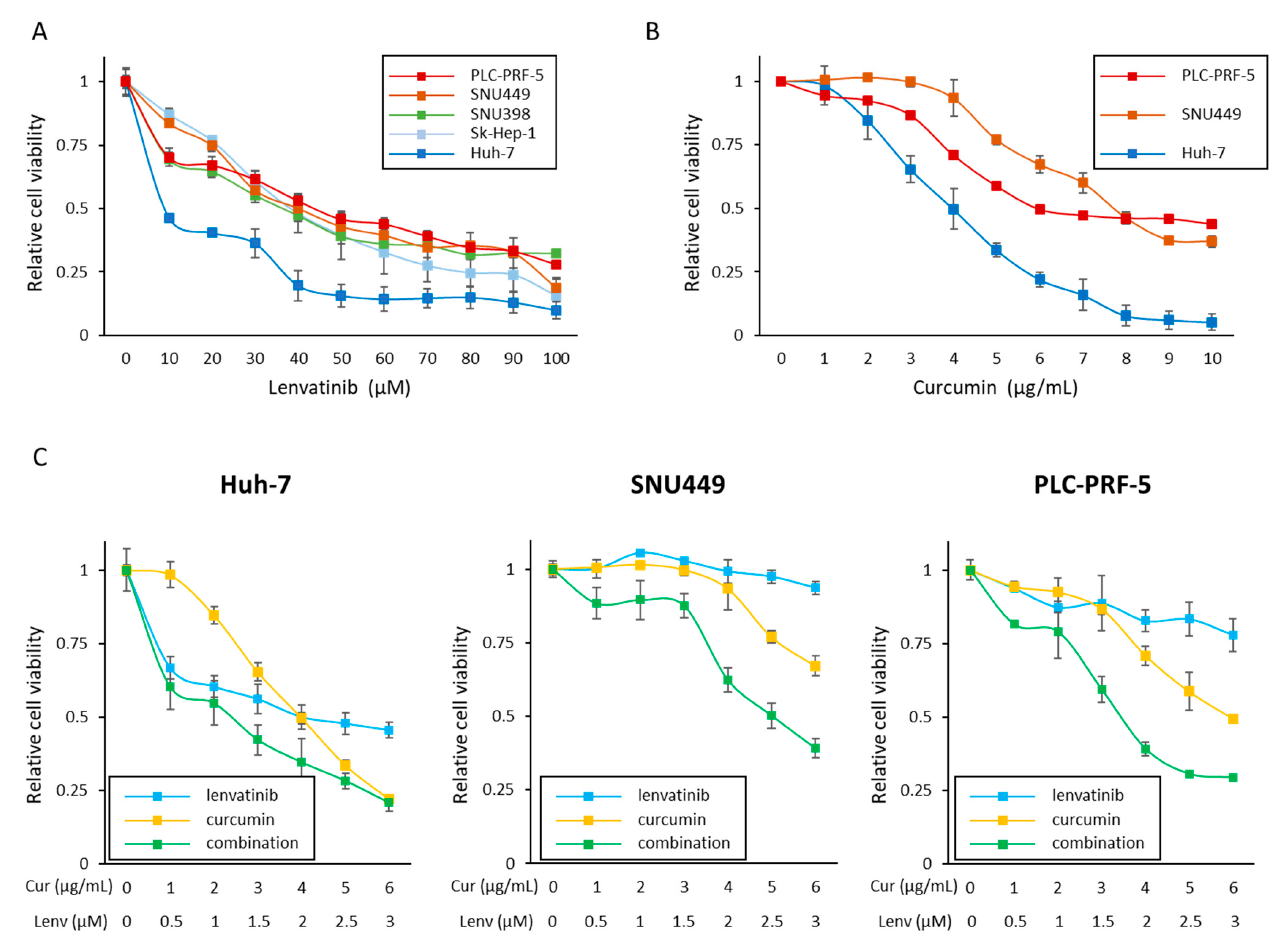
Figure 1. Curcumin enhanced the anti ‐ proliferative effects of Lenvatinib in parental HCC cells. ( A ) Cell viability assay following Lenvatinib treatment for 48 h in five HCC cells. ( B ) Cell viability assay following 48 h of treatment with Curcumin in Huh ‐ 7, SNU449, and PLC ‐ PRF ‐ 5 cell lines. ( C ) Cell viability assay following Curcumin and Lenvatinib combination treatment for 48 h in Huh ‐ 7, SNU449, and PLC ‐ PRF ‐ 5 cell lines. Error bars in all panels represent the mean ± SD. SD, standard deviation.